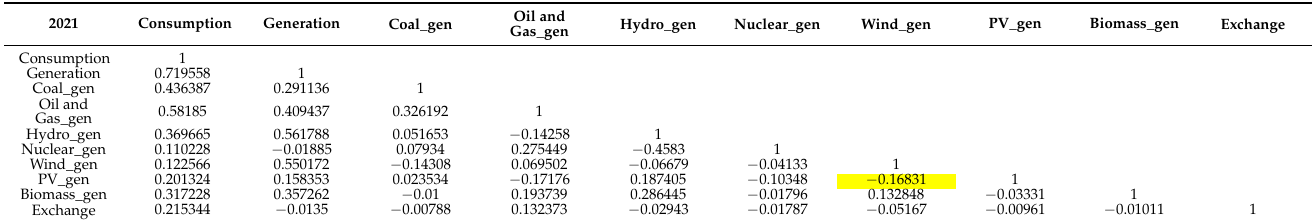
Table 3. Correlation coefficients between consumption and generation sources in 2021.